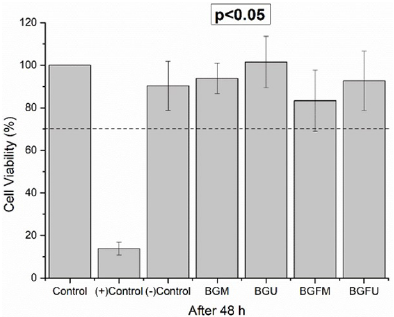
Figure 11. HEK293 T cells viability by MTT assay for 48 h.